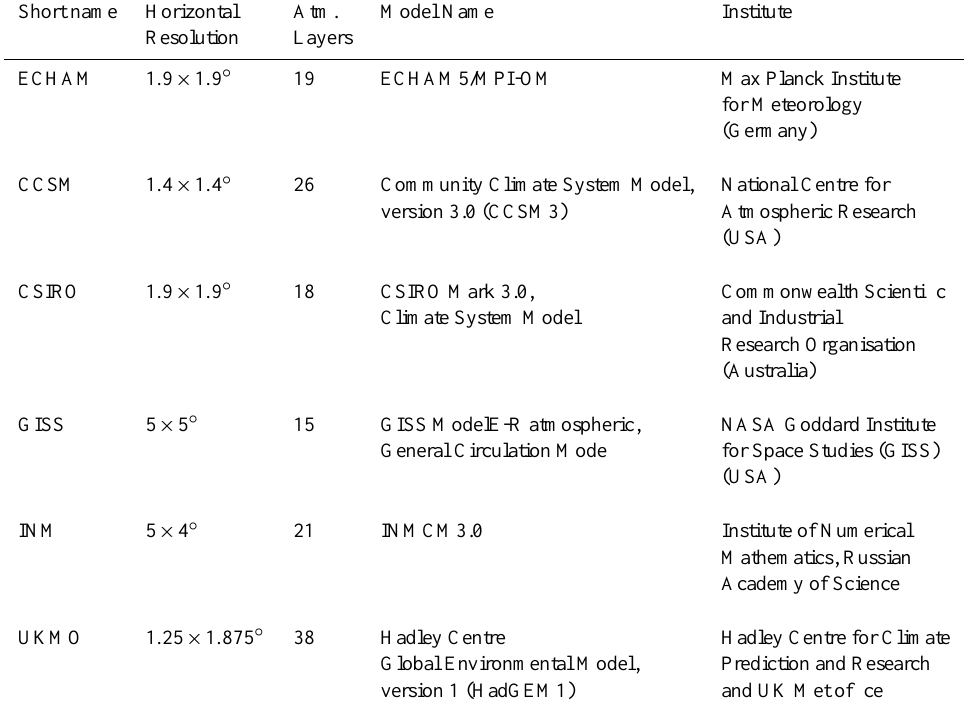
Table 1. IPCC Global Climate Models. This table provides an overview of the resolution and country of origin for the subset of IPCC AR4 models used in this